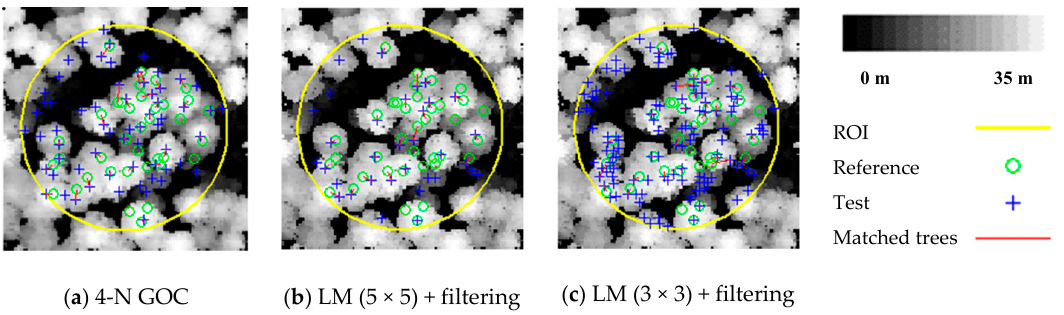
Figure 11. Matching results of 4-N GOC and LM + filtering methods.